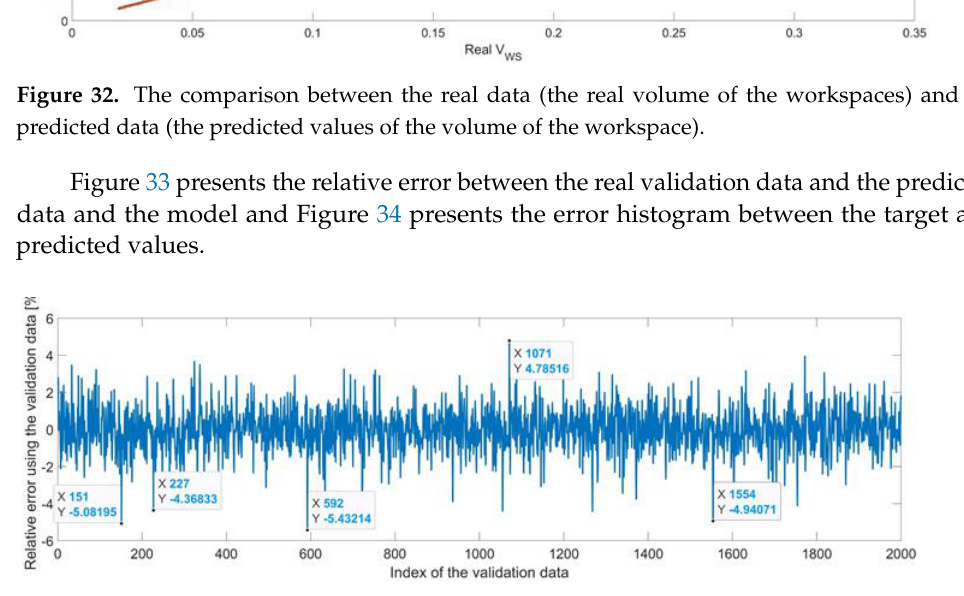
Figure 32. The comparison between the real data (the real volume of the workspaces) and the predicted data (the predicted values of the volume of the workspace).